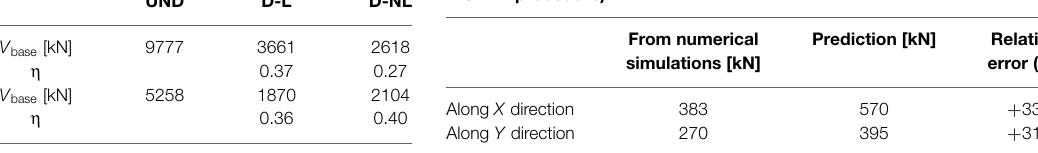
TABLE 8 | Maximum damper forces in the linear dampers (according to the MCEER procedure)